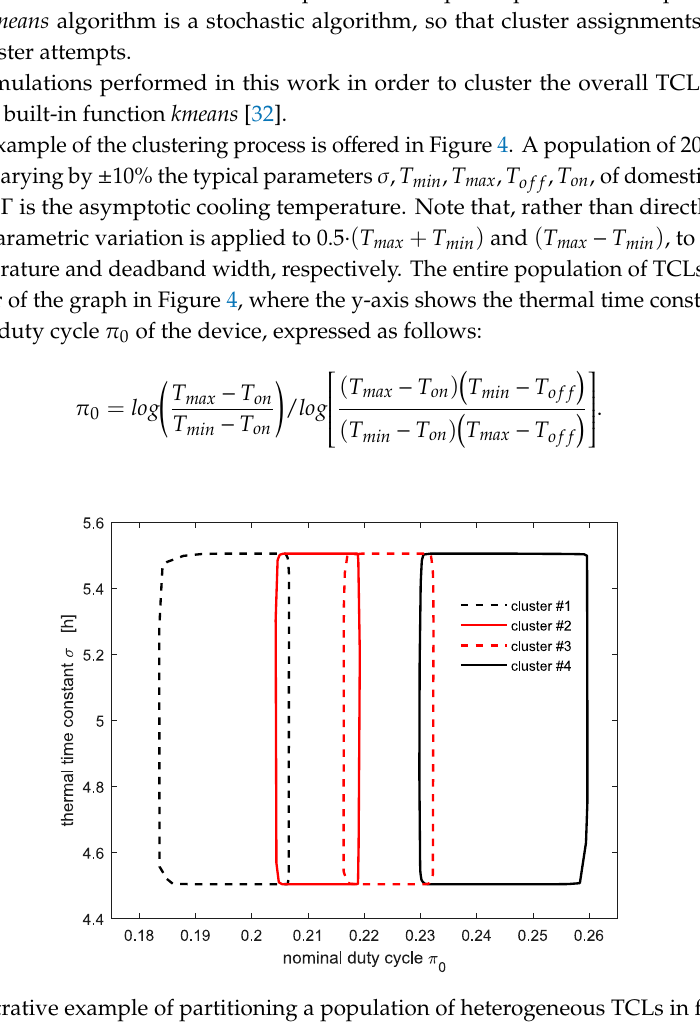
Figure 4. Illustrative example of partitioning a population of heterogeneous TCLs in four clusters. Low values of 𝜎 may indicate TCLs with poor insulation. Similarly, clusters with large values of 𝜋 (cid:2868) include TCLs that would on average absorb more